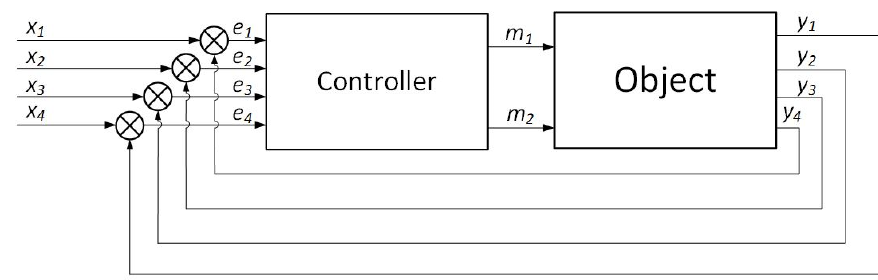
Figure 3. Schematic of the cogenerator control